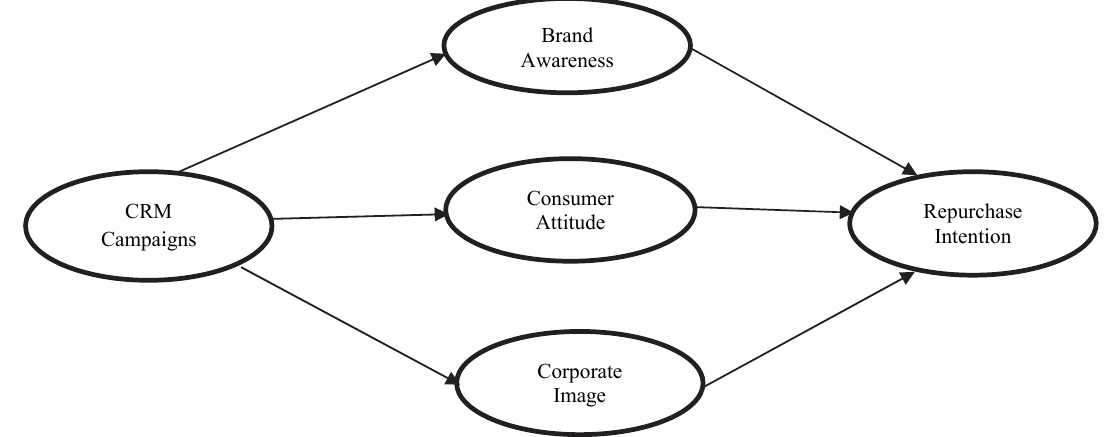
Fig. 1. Conceptual Research